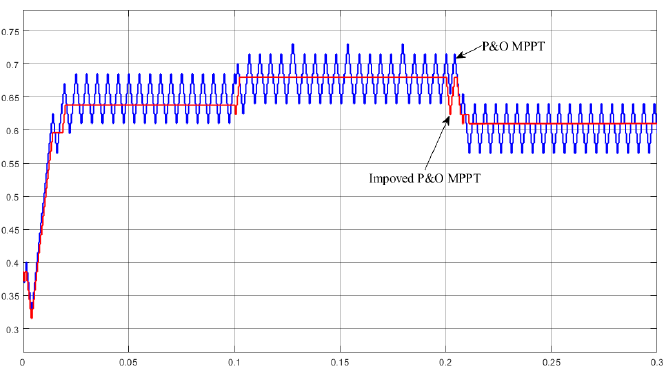
Figure 19. Duty cycle of P&O MPPT and improved P&O MPPT.